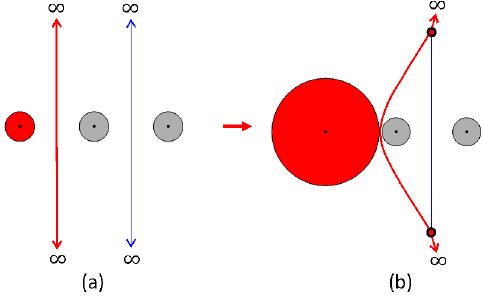
Fig. 13 Disconnected edges in the cell-expansion